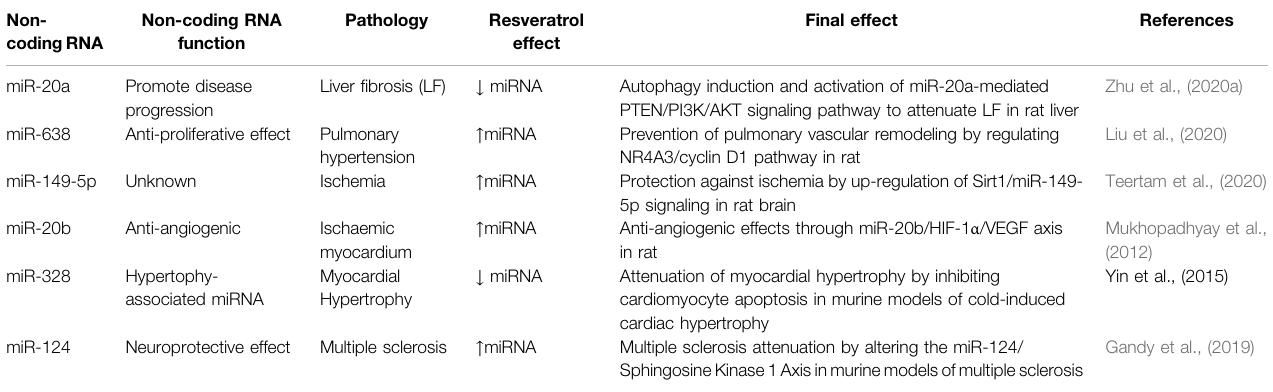
TABLE 3 | Liver fi brosis, pulmonary vascular remodeling, low ambient cardiovascular disease, multiple sclerosis, ischemia, and osteoporosis. Non-